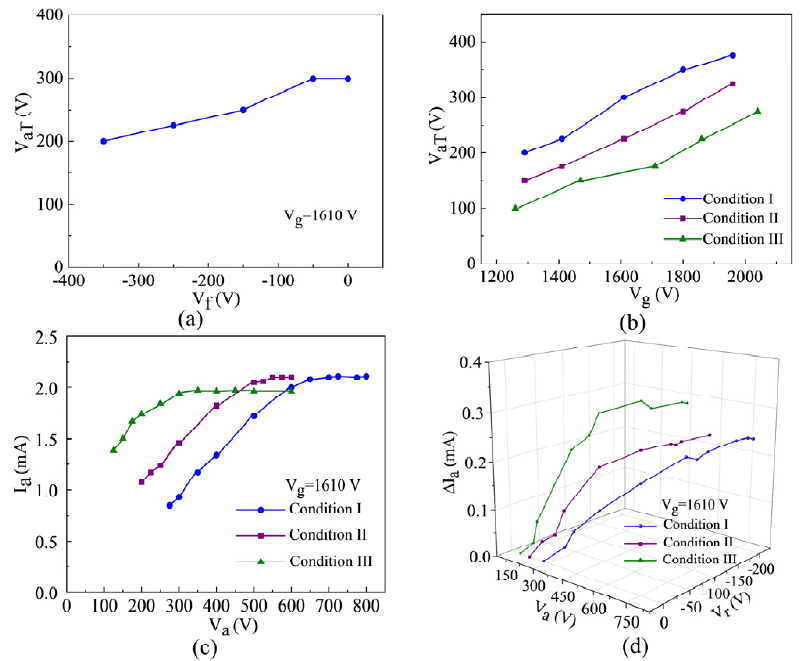
Figure 5. ( a ) V aT as a function of V f . Under three test conditions: ( b ) V aT as a function of V g ; ( c ) I a as a function of V a , where V g is at 1610 V; ( d ) ∆ I a as a function of V a and V r , where V g is at 1610 V.